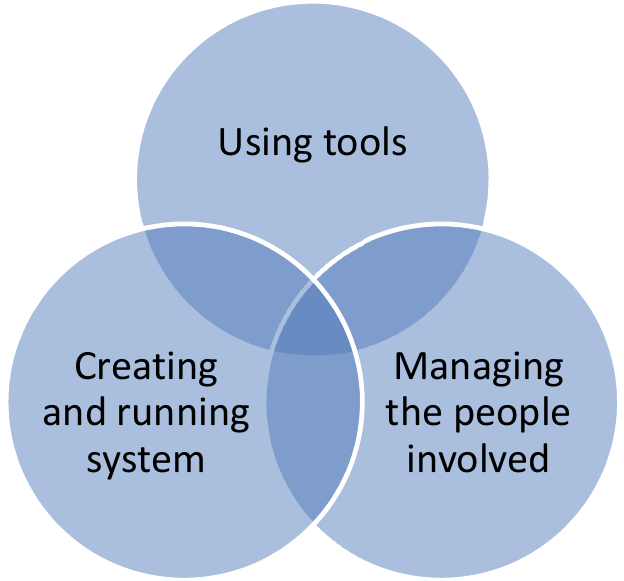
Fig. 1. Dimensions required for the success of the project management (Scott-young,